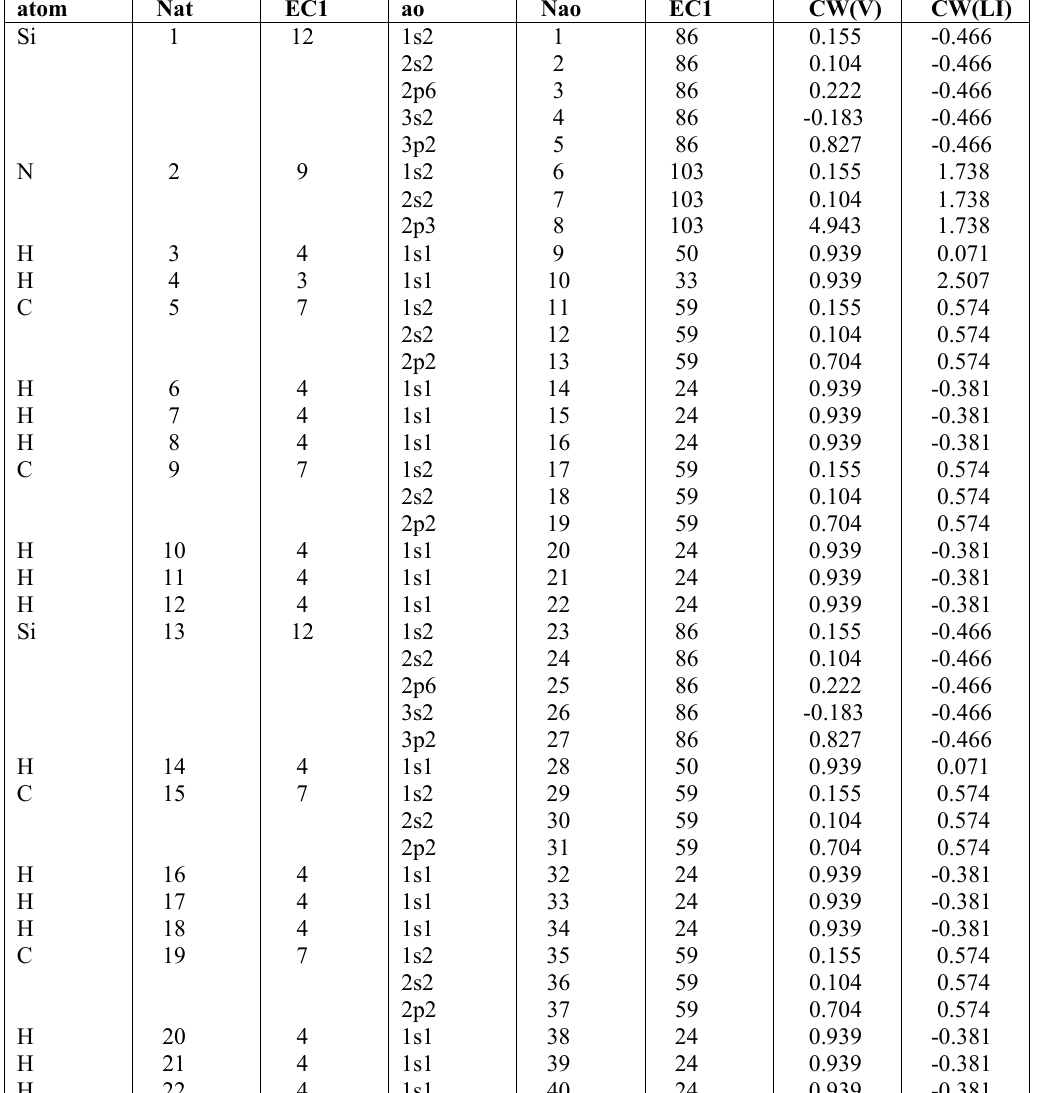
Table 2 . Calculation of the DCW 1 for 1,1,3,3-tetramethyldisilazane (DCW 1 =